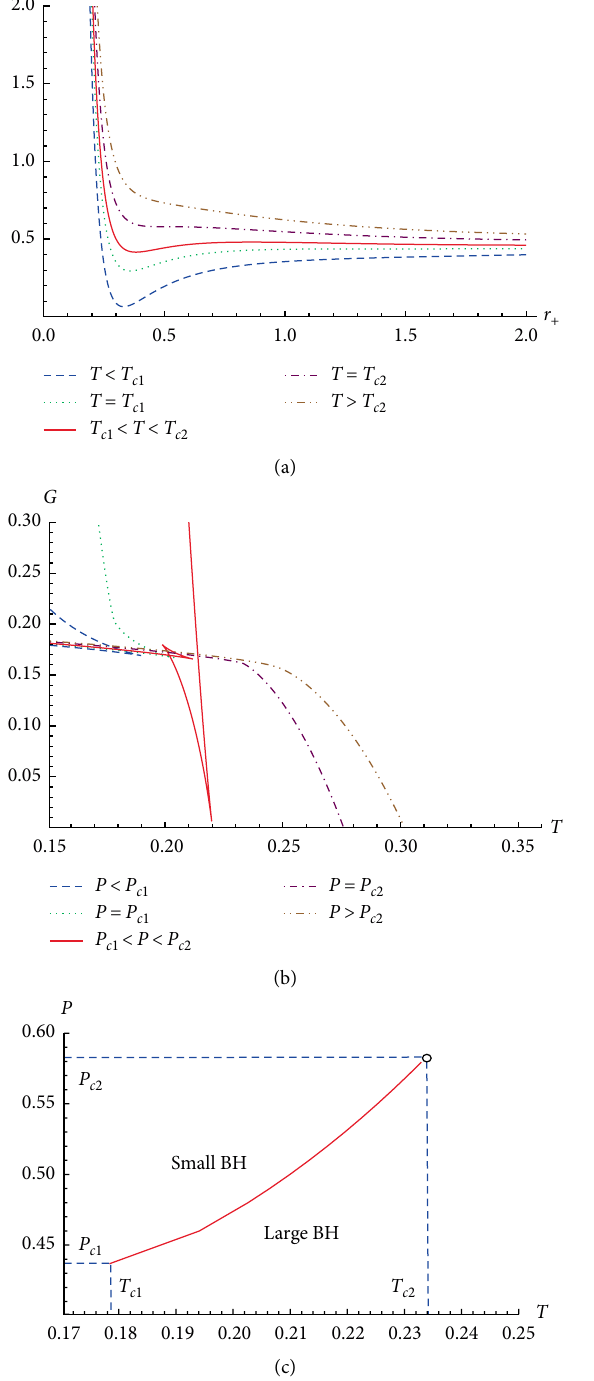
, 𝐺 − 𝑇 , and 𝑃 − 𝑇 diagrams of four- + = − 1.03 , 휉 = − 2.4 , 𝑝 = 0.4 . The VdW-like SBH/LBH phase transition 𝑝 and 𝑃 < 𝑇 < 𝑇 < 𝑃 < 𝑃 푐1 푐2 푐1 푐2